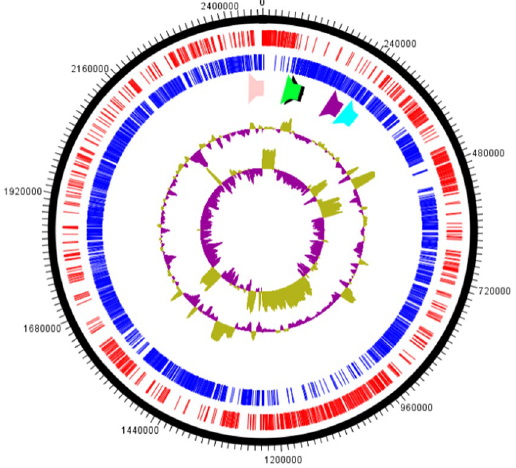
Figure 3. Graphical circular map of the genome from strain Marseille-P3254. From outside to the center: genes on the forward strand colored in dark blue, genes on the reverse strand colored in red, the five resistance genes identified by comparison with the ARG-ANNOT database colored in pink, green, black, purple and light blue, G + C content and G + C skew.